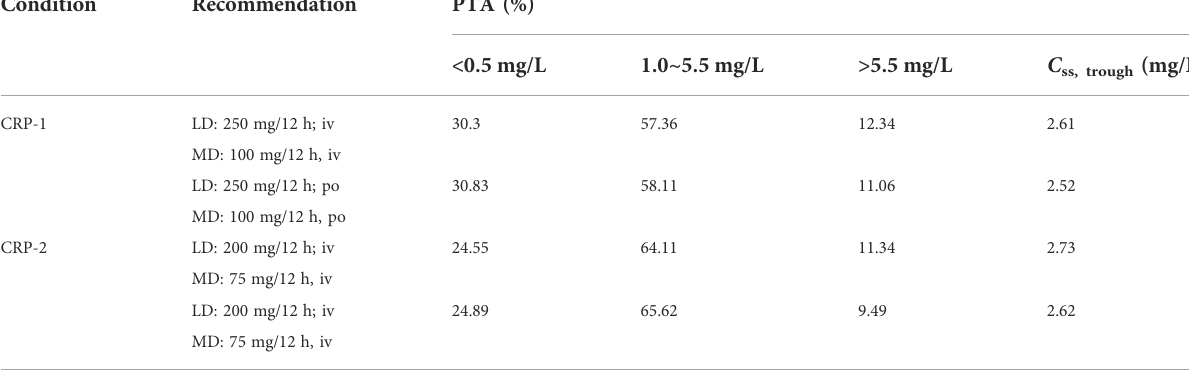
TABLE 4 Recommended initial dosing regimen of voriconazole for patients in the two groups.